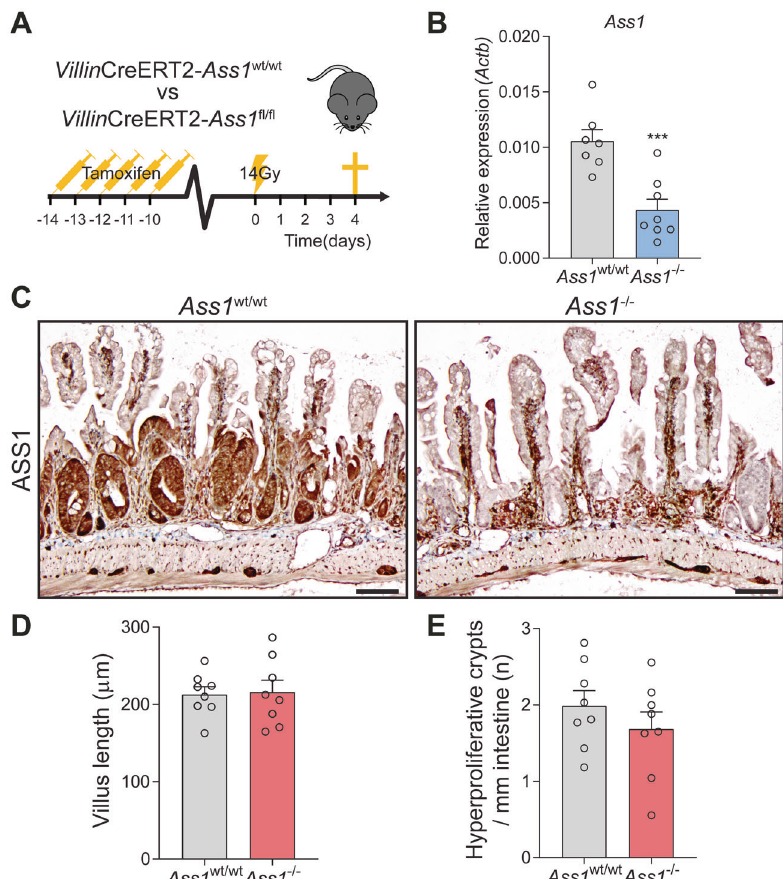
Fig. 4 Ass1 knockout in the intestinal epithelium does not affect regeneration after damage by irradiation. A Schematic overview of the mouse model. B qRT-PCR for Ass1 in small intestinal lysates of Ass1 wt/wt and Ass1 − / − mice 96 h after irradiation. Actb was used as a reference gene. *** p < 0.001 by Student ’ s t -test. C Immunohistochemistry for ASS1 in small intestinal tissue of Ass1 wt/wt and Ass1 − / − mice 96 h after irradiation. Representative images shown. Scale bar indicates 100 µm. D Average villus length. E Amount of hyperproliferative crypts per mm intestine. n = 8 mice per